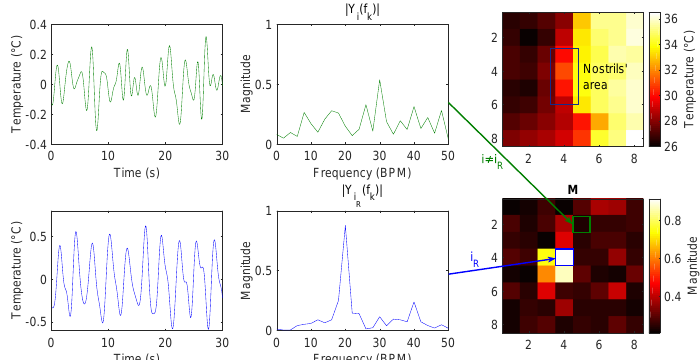
Figure 2. The upper plots show the time domain signal and spectrum of a pixel where no respiratory information is present. The plots on the second row show the time domain and spectrum of another pixel that contains a respiration signal; whereas, the upper figure shows a thermal image where a subject is in a profile view at 20 cm from the sensor, the lower one showing the distribution of the normalized spectrum’s peak calculated per each pixel, i.e., M resulting from Equation (3). The pixels containing the signals plotted are indicated. BPM, Breaths Per